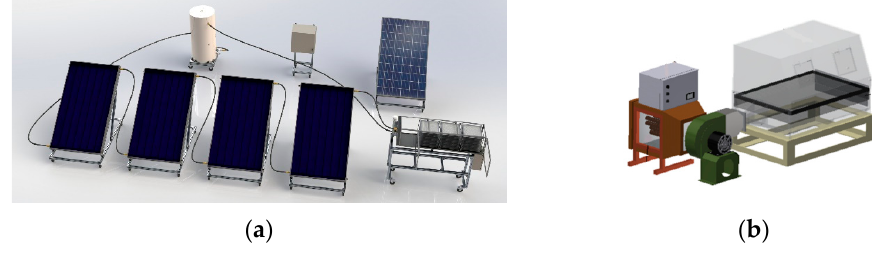
Figure 1. Mixed-mode tunnel-type solar dryer ( a ) and electric dryer ( b